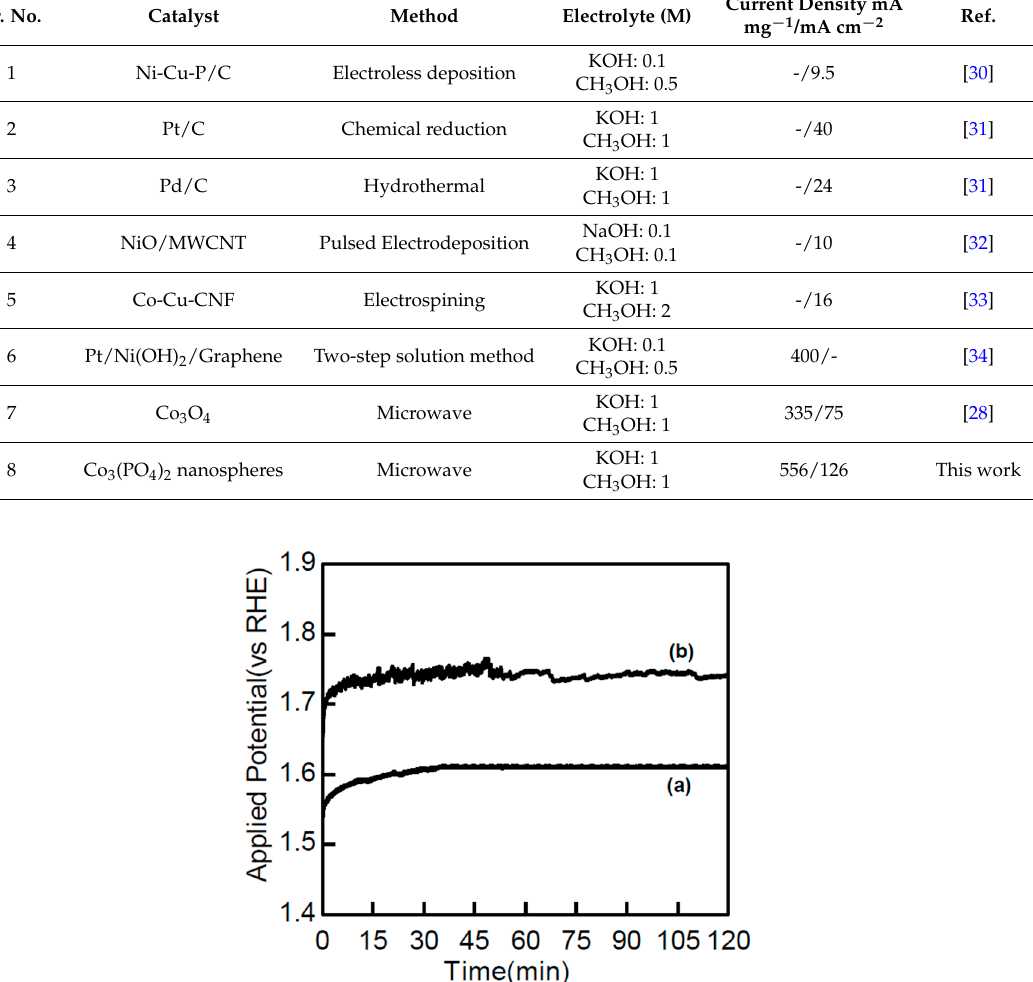
Table 1. Specific and mass activities of nickel- and cobalt-based catalysts for methanol oxidation in alkaline media. Sr. No.